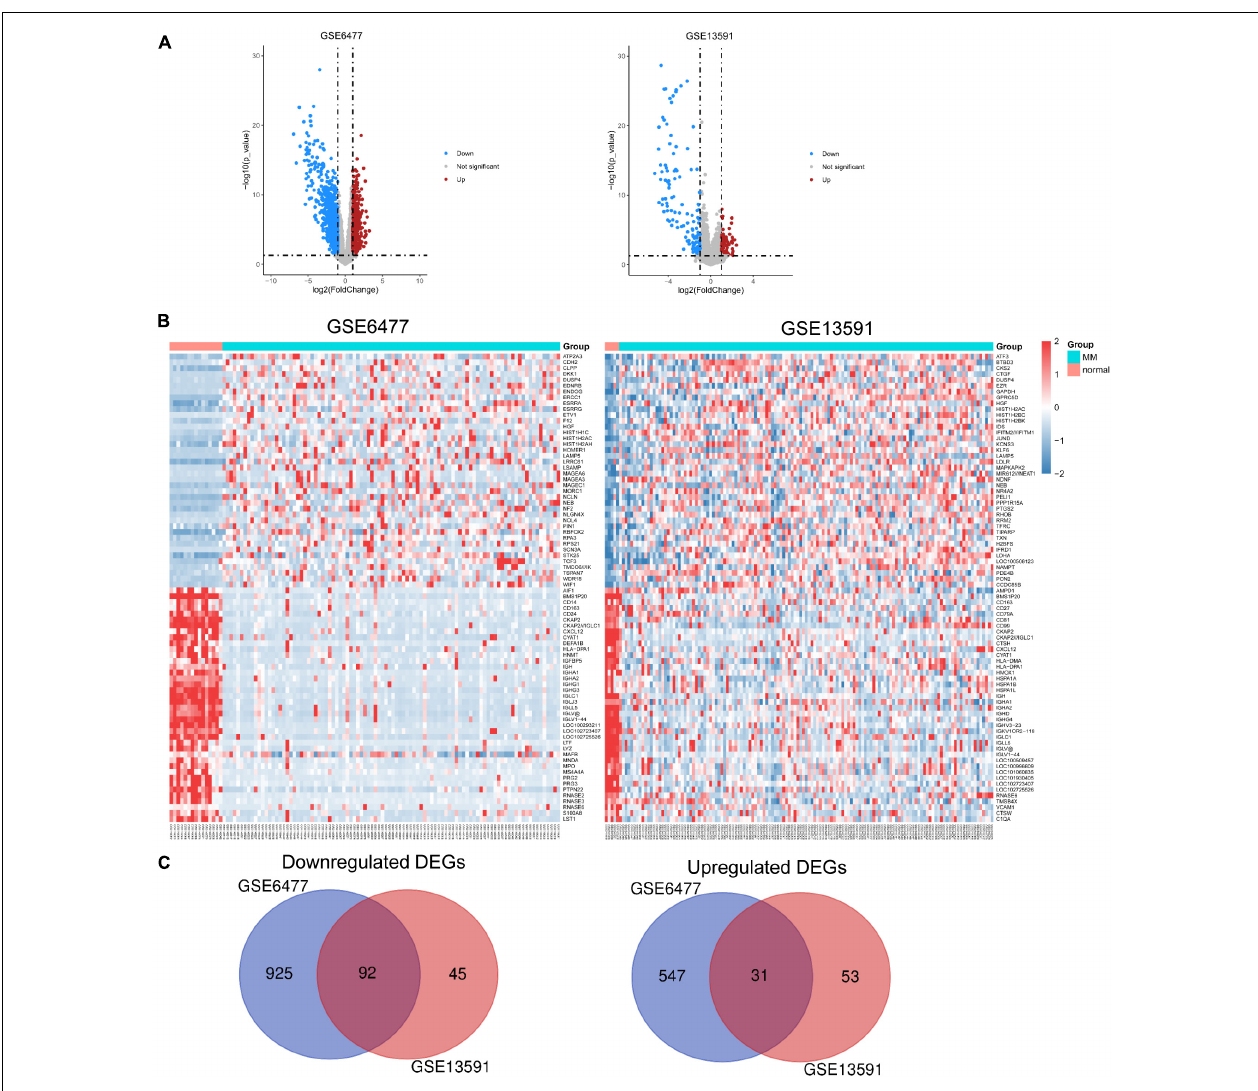
FIGURE 1 | Identification of DEGs in each GEO dataset. (A) Volcano plots of the distribution of DEGs in GSE6477 and GSE13591. (B) Heatmap of the top 40 DEGs in GSE6477 and GSE13591. (C) Commonly downregulated or upregulated DEGs in GSE6477 and